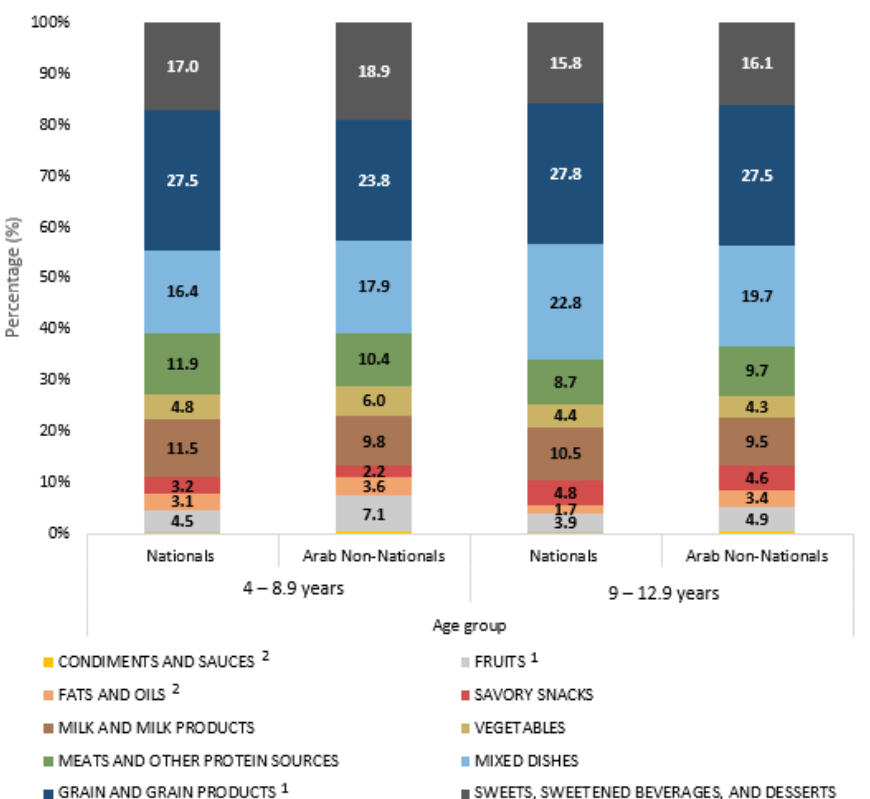
Figure 2. Mean percentage of energy from various food groups among UAE children aged 4 to 12.9 years separated by age and nationality, KNHS 2021. 1 Indicates significant difference ( p < 0.05) between nationals and non-nationals amongst 4 – 8.9 year-old children. 2 Indicates significant difference ( p < 0.05) between nationals and non-nationals amongst 9 – 12.9 year-old children.